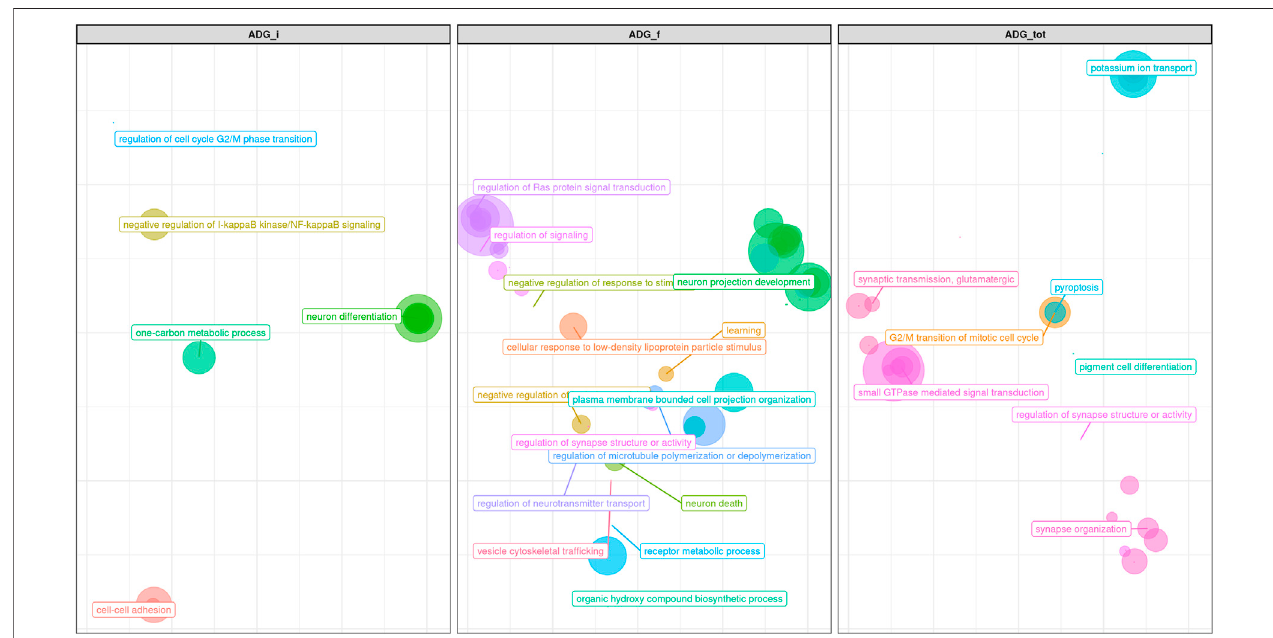
FIGURE 9 | Scatter plot representing the main groups of biological pathways enriched for average daily gain traits measured at fi rst, half and total period of performance test (ADG_i, ADG_f, ADG_tot); the area represents the number of pathways in that group, among the total. For a detailed list of the pathways enriched by these traits see Supplementary Figures S4D – F